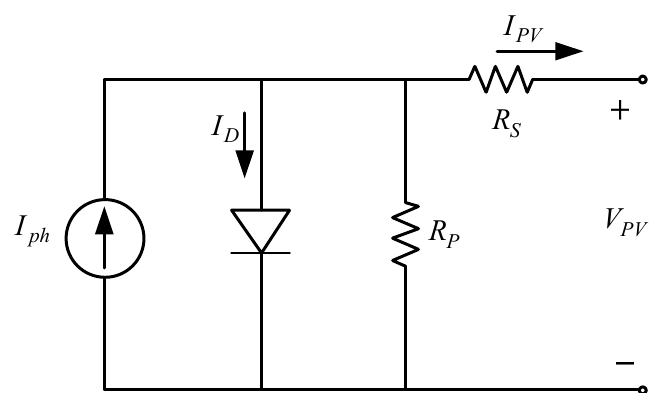
Figure 1. Single-diode equivalent circuit model.